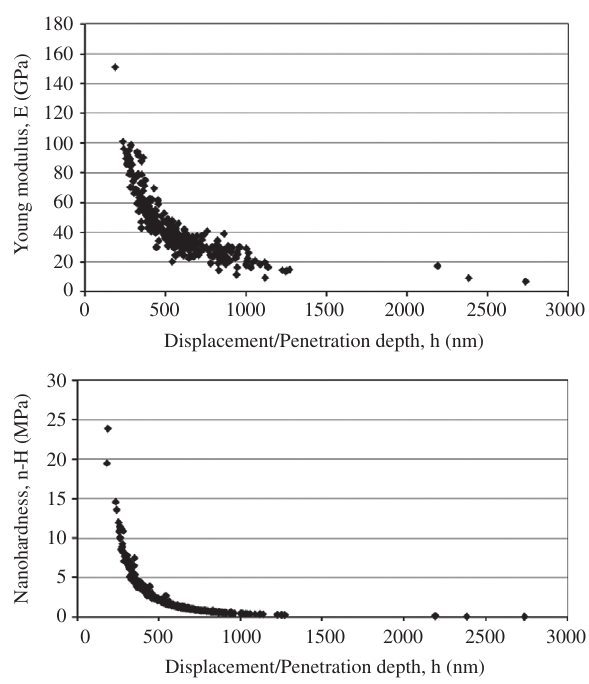
Figure 5 Scatter plots of E (upper) and n-H (lower) vs. penetration